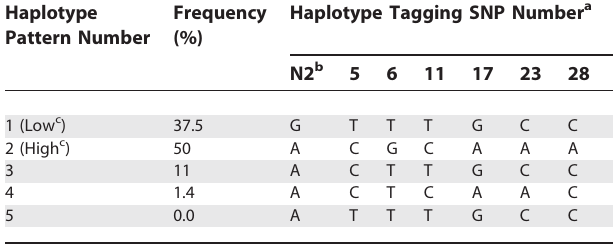
a The seven SNPs assayed here are KRT1 haplotype block tagging SNPs that together differentiate between the five major haplotype patterns. The full haplotype patterns are shown in Table S2. b SNP2 is the exonic SNPs assayed for differential allelic expression. c Haplotypepattern 1is the low-expressinghaplotype andhaplotypepattern 2 is thehigh- expressing haplotype, as determined by expression levels of SNP2 in the 36 white blood cell